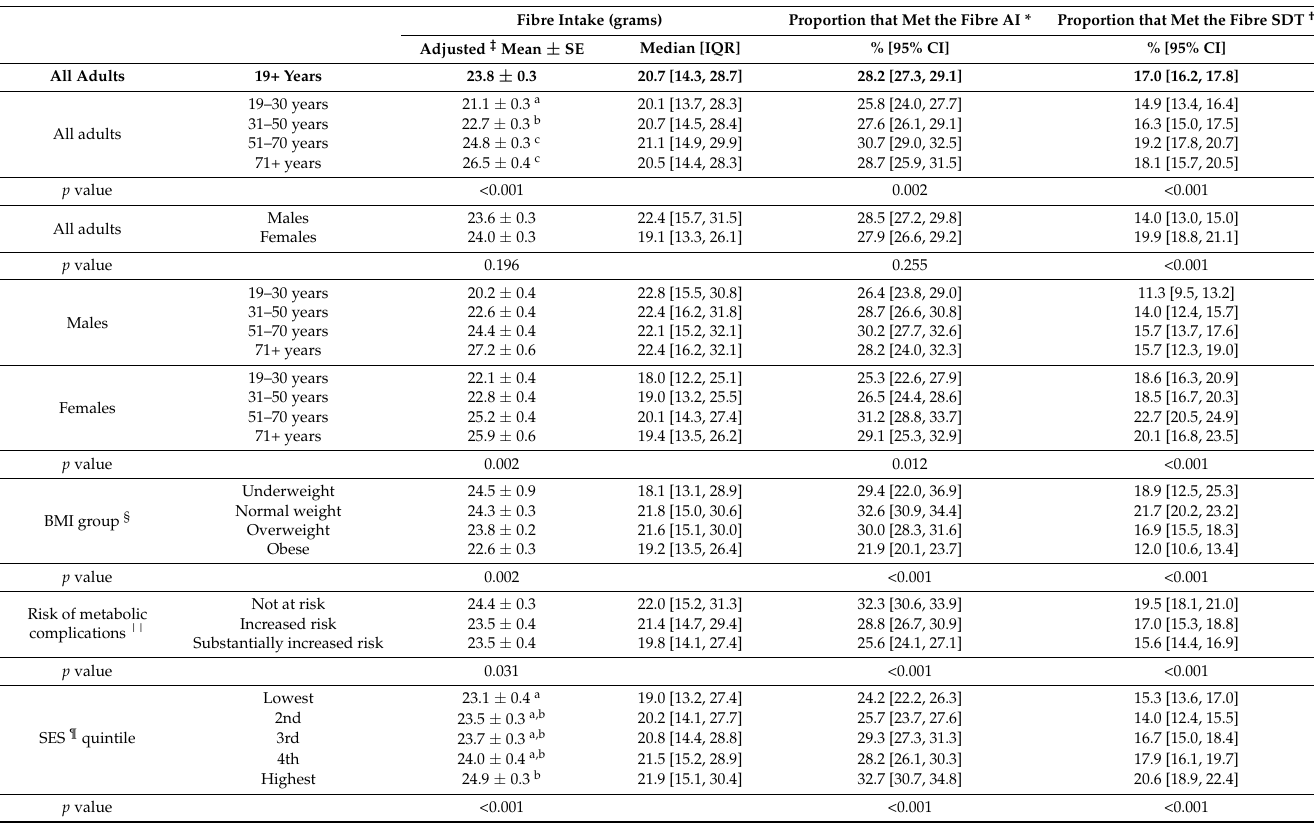
Table 3. Total daily fibre intake and the proportion of adults aged 19 years and over that met the fibre AI and SDT by age, sex, SES, and anthropometric